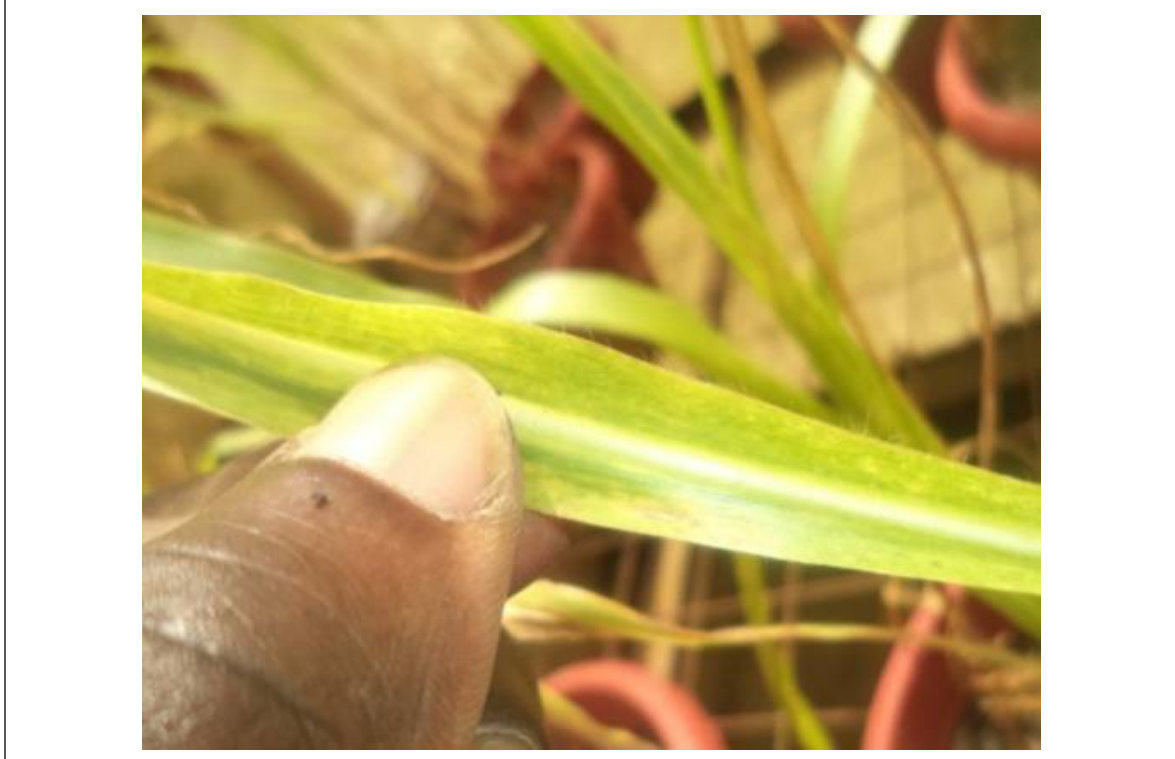
Figure 1: Maize chlorotic mottle virus symptoms observed in Imperata cylindrica grass weed species following mechanical